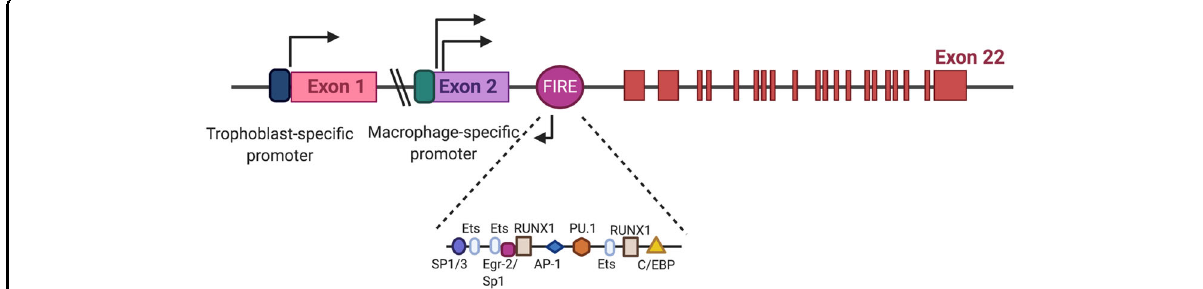
Fig. 1 Genomic structure of the mouse Csf1r locus. Both human and mouse Csf1r genes consist of 22 exons and 21 introns (upper panel). Exon 1 is only expressed in trophoblasts through activation of the trophoblast-speci fi c promoter. The human trophoblast-speci fi c promoter is located 20 kb upstream of exon 1. Csf1r transcription in macrophages starts from the promoter that is upstream of exon 2. Neither promoter has a TATA box. The Fms-intronic regulatory element (FIRE) is a highly conserved regulatory element that produces antisense transcripts to overcome the unknown repressive elements in intron 2. Several transcription factors known to bind to the FIRE have been characterized (lower